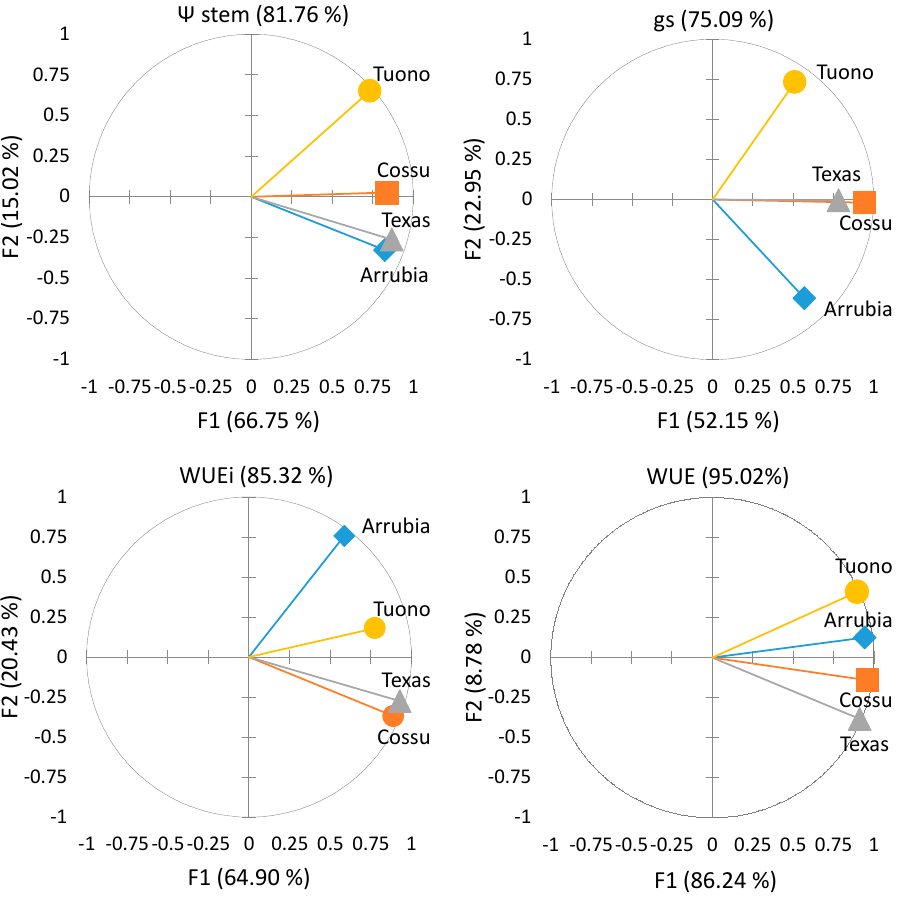
Figure 6. Principal Component Analysis (PCA) plots showing the variation among the four cultivar in terms of midday stem water potential ( Ψ stem ), stomatal conductance (gs), intrinsic water use efficiency (WUEi), and transpiration efficiency (WUE) during nut growth stage of the two-year study period. Data are the mean of each tree replicate from 11 dates of measurements (n = 55).